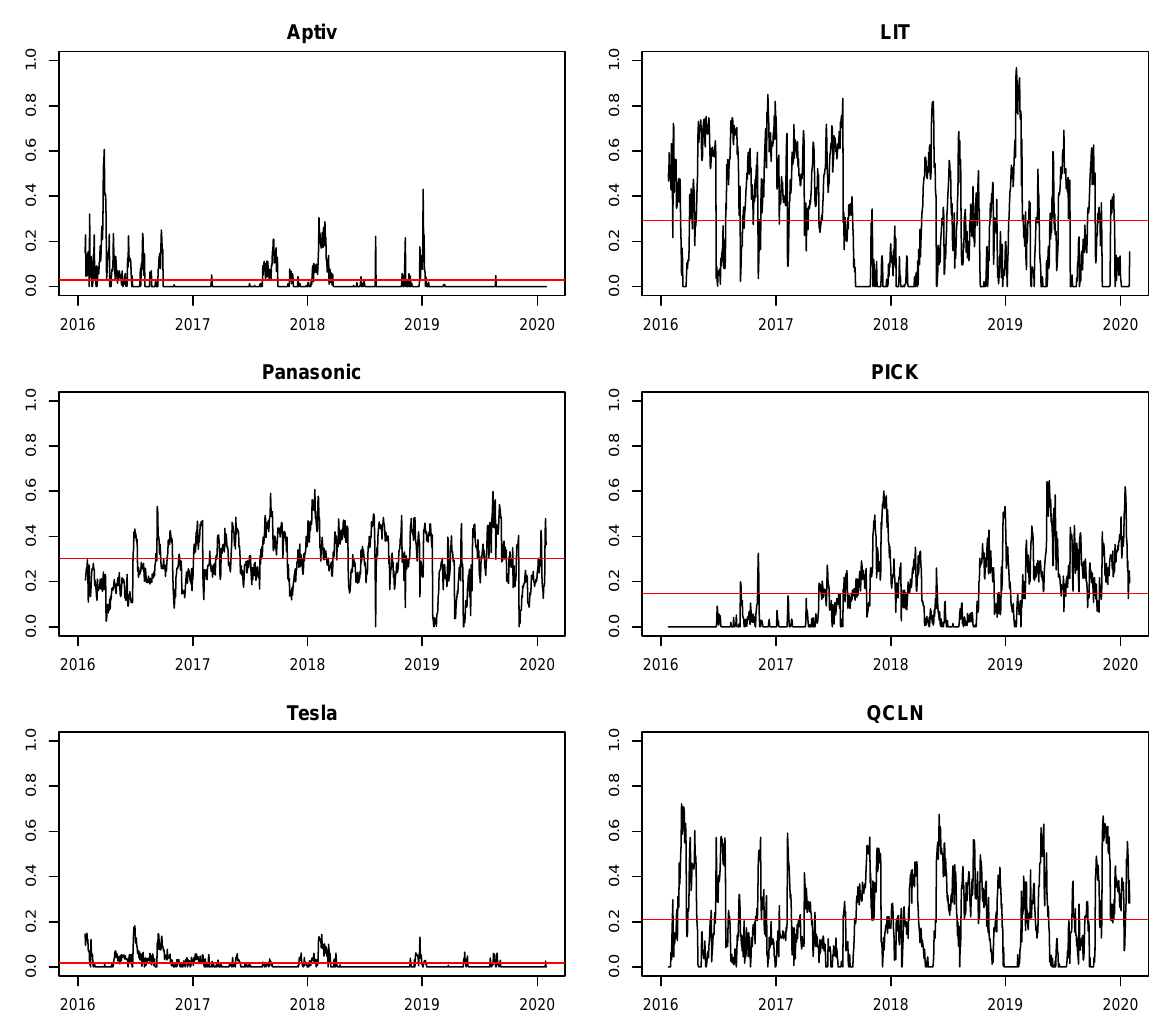
Figure 5. Optimal portfolio weights for GARCH(1,1)-JSU marginals and vine copulas. Note: The horizontal lines are the average weights over the test